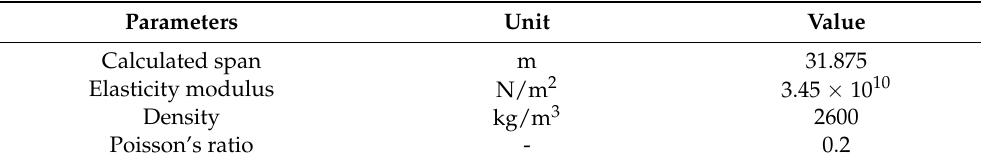
Figure 6. Finite element model of box girder and schematic diagram of loading point of mid-span cross-section; ( a ) the finite element model of box girder; ( b ) the schematic diagram of loading point of mid-span cross-section. Table 3. Parameters of the box